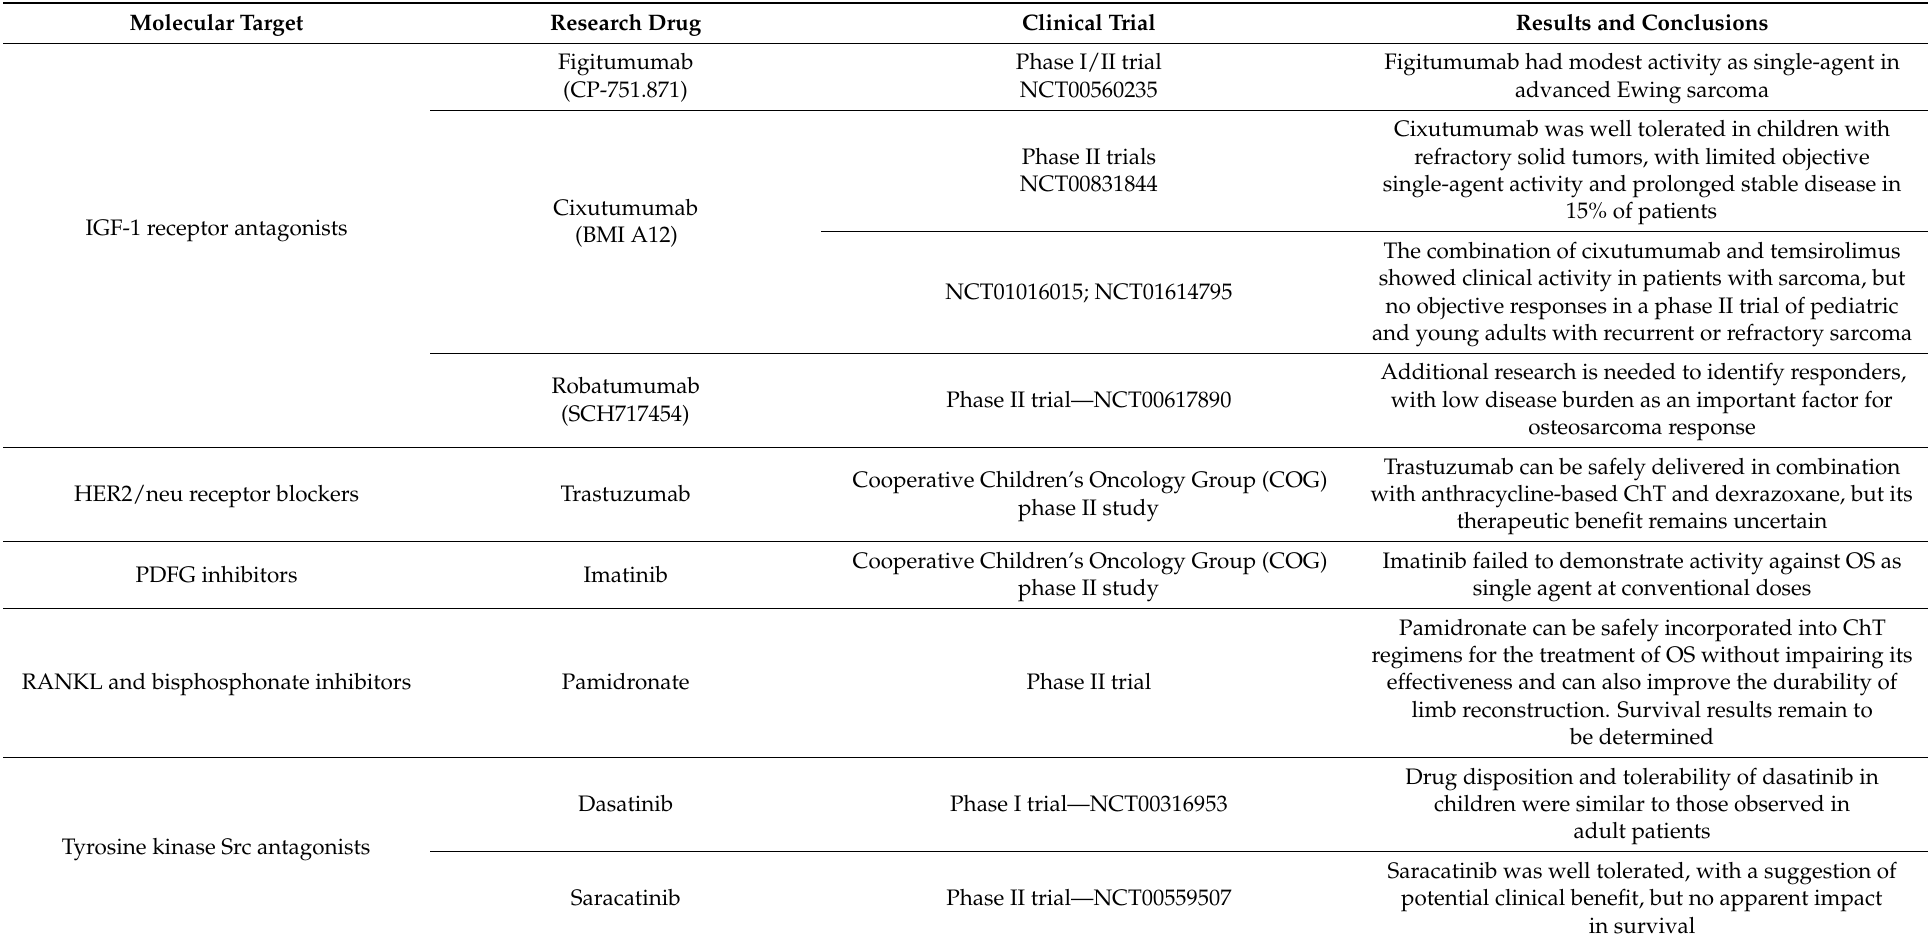
Table 1. Clinical trials with potential new molecular